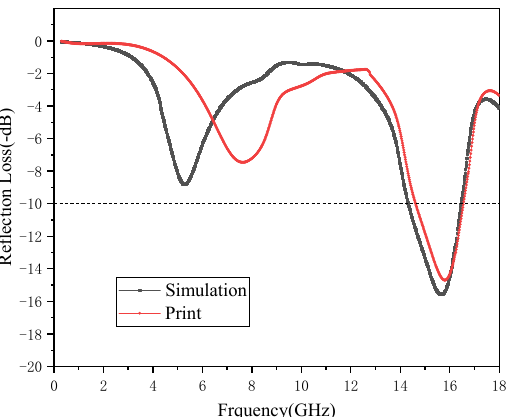
Figure 13. RL spectra of the printed honeycomb absorber and simulated honeycomb model.